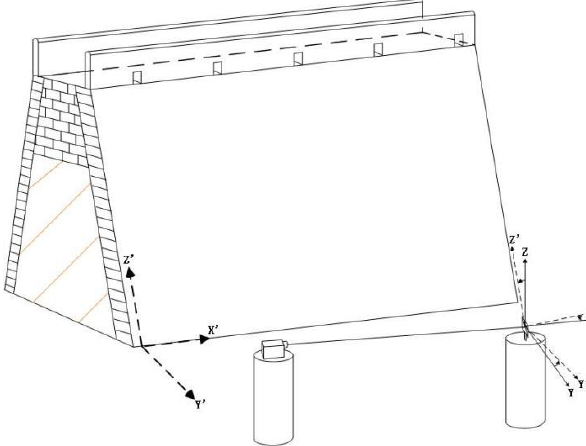
Figure 5 .Coordinate conversion